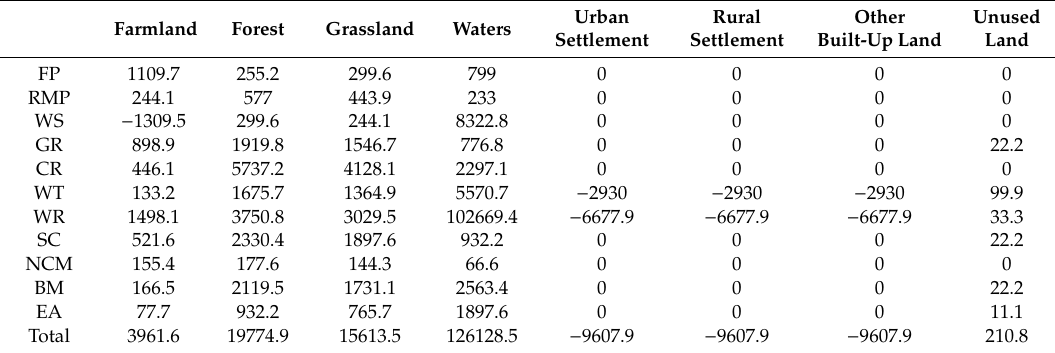
Table 2. Ecosystem service value (ESV) per unit area of Puge County (yuan / hm 2 ). Farmland Forest Grassland